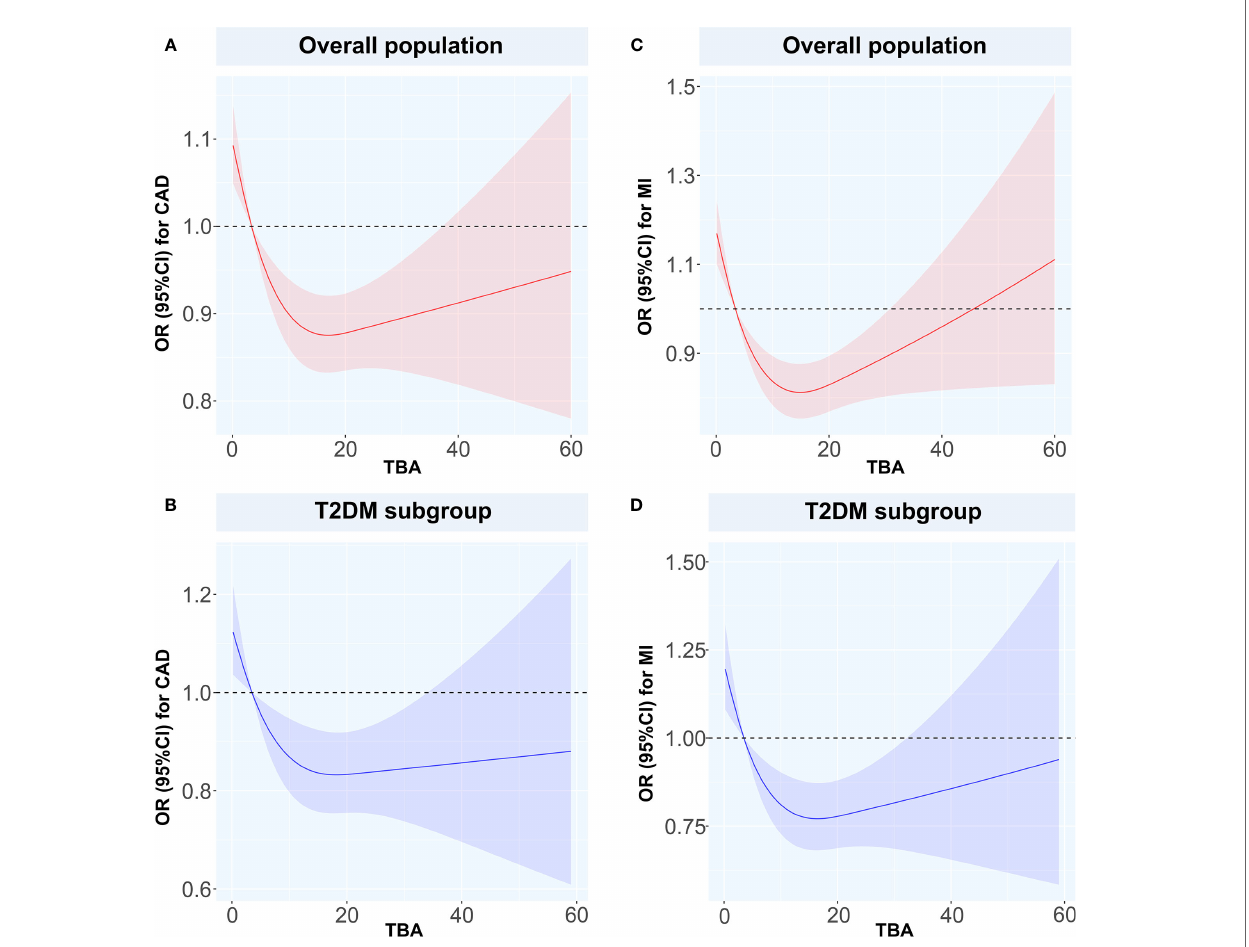
FIGURE 3 | Restricted spline curves for the associations between TBA and MI or CAD Solid red and blue lines represent the odds ratio, and red and blue dashed area represent the 95% con fi dence intervals. (A) the relationship between TBA and CAD in overall population, (B) the relationship between TBA and CAD in T2DM subgroup, (C) the relationship between TBA and MI in overall population, (D) the relationship between TBA and MI in T2DM subgroup. TBA, total bile acid; CAD, coronary artery disease; MI, myocardial infarction; T2DM, type 2 diabetes mellitus; OR, odds ratio; CI, con fi dence